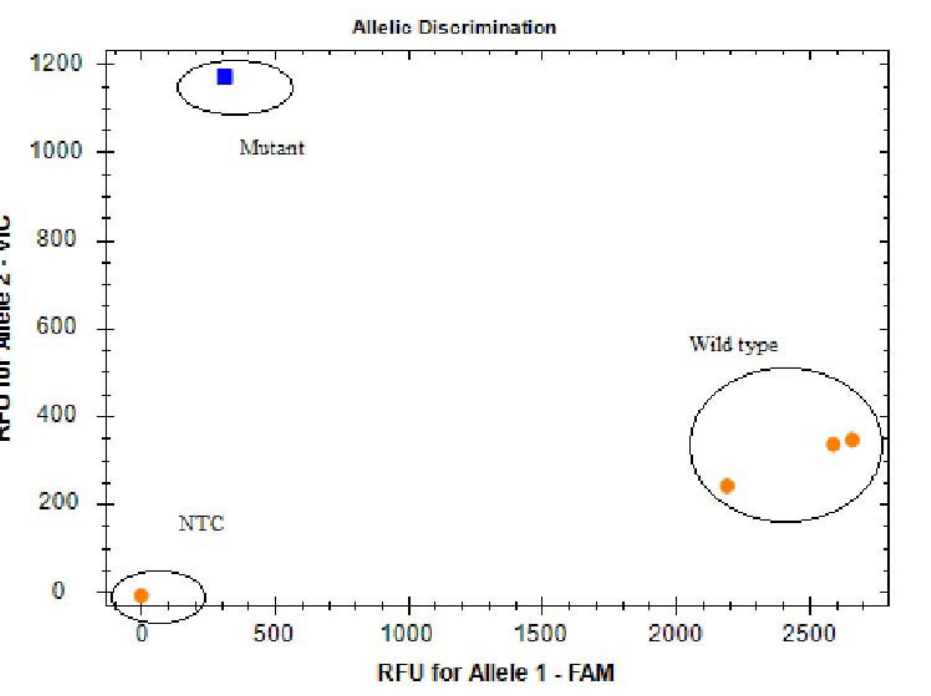
Fig. 1. Real Time RT PCR Allelic discrimination plot for detection of substitution at amino acid 275 in